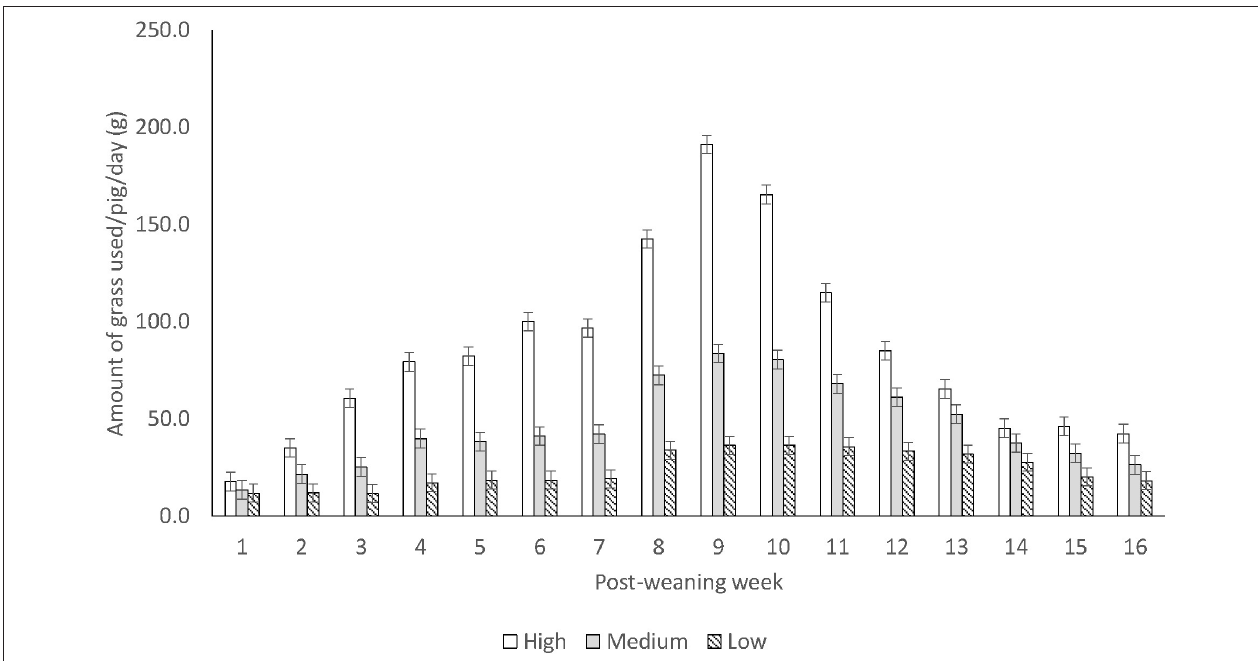
FIGURE 2 | Mean ( ± s.e.) amount of grass (g/pig/day) used between treatments over weeks post-weaning ( P < 0.001). Weaner stage was from week 1–7 and finisher stage from week 8–16. “High” pigs were checked/replenished 3 times per day, “Medium” pigs once each morning, and “Low” pigs 3 times a week